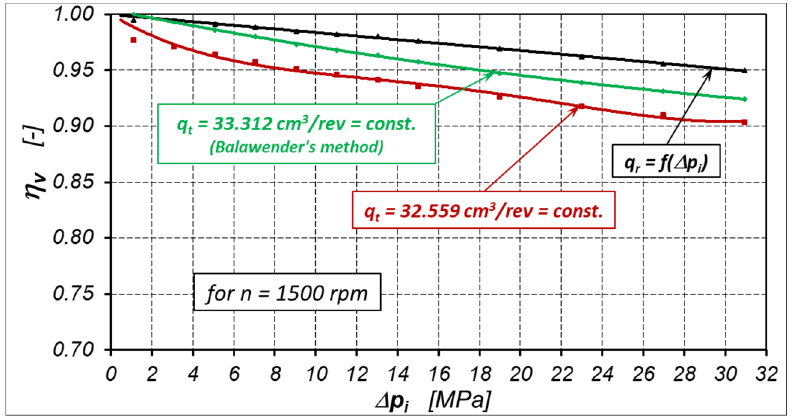
Figure 17. Volumetric efficiency η v = f( Δ p i ) of satellite motor at n = 1500 rpm for q r and q t calculated according to the Balawender’s method and the new method.